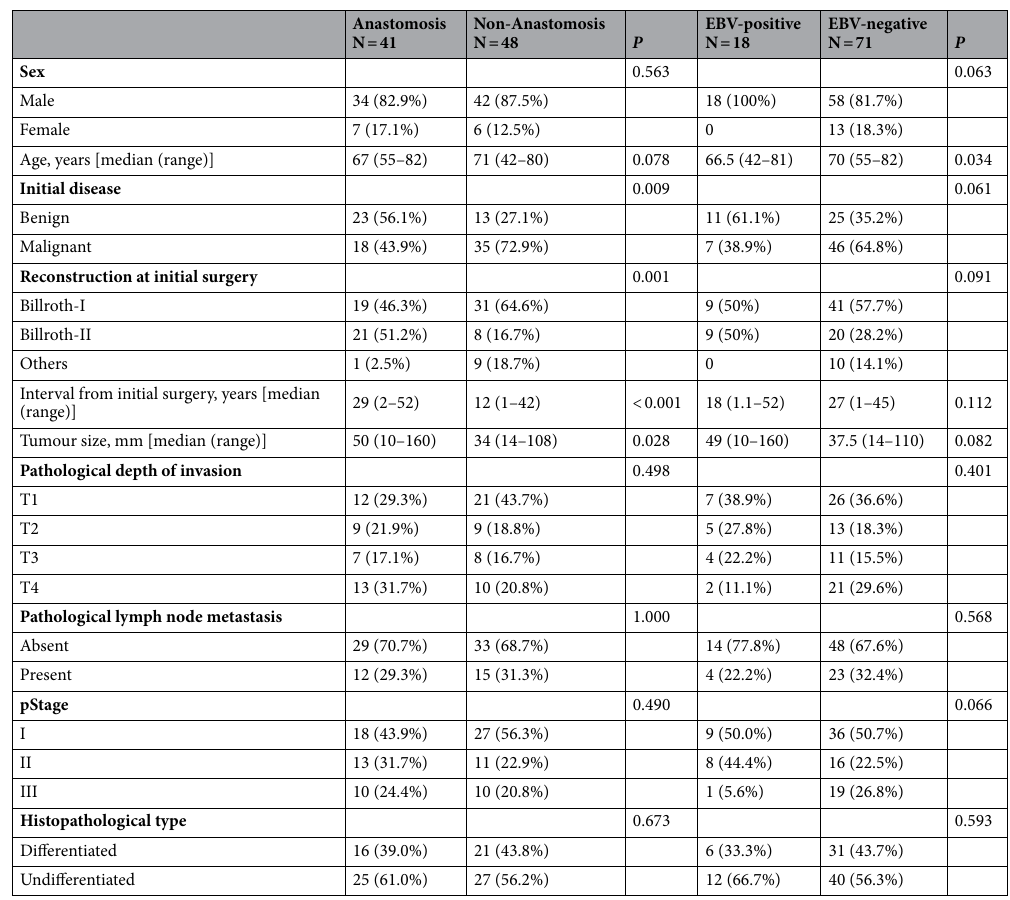
Table 4. Comparison of clinicopathological factors between patients with gastric stump cancer (GSC) in the anastomotic area (Anastomosis) or other areas (non-Anastomosis) and GSCs with EBV positivity or negativity. The pathological stage as well as T and N numbers were defined using the 8th TNM classification. Histopathological types were classified in accordance with the Japanese classification of gastric